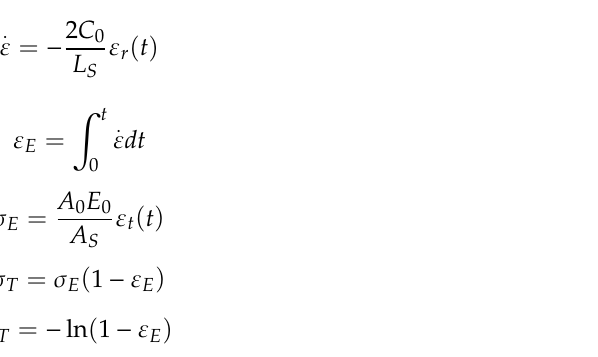
Table 3. Loading pressures and strain rates of specimens.